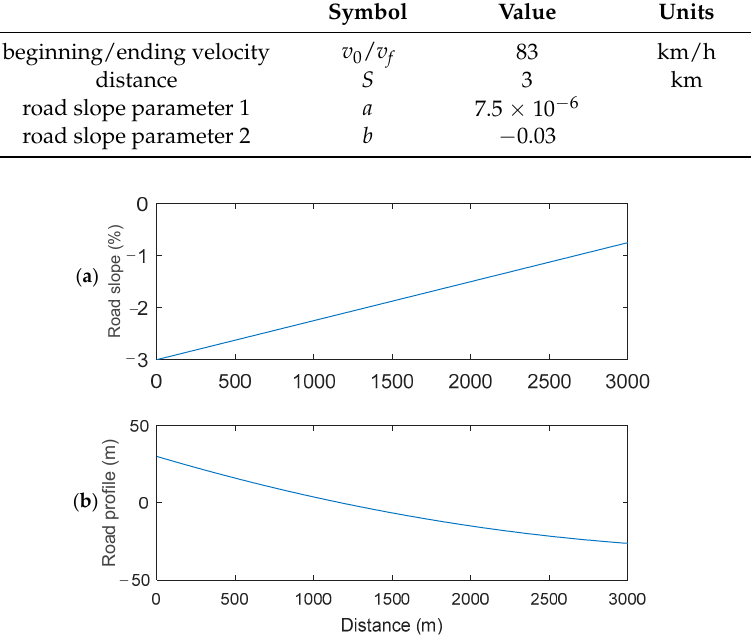
Figure 8. Concave road profile and its road slope. ( a ) Road slope profile; ( b ) road profile.